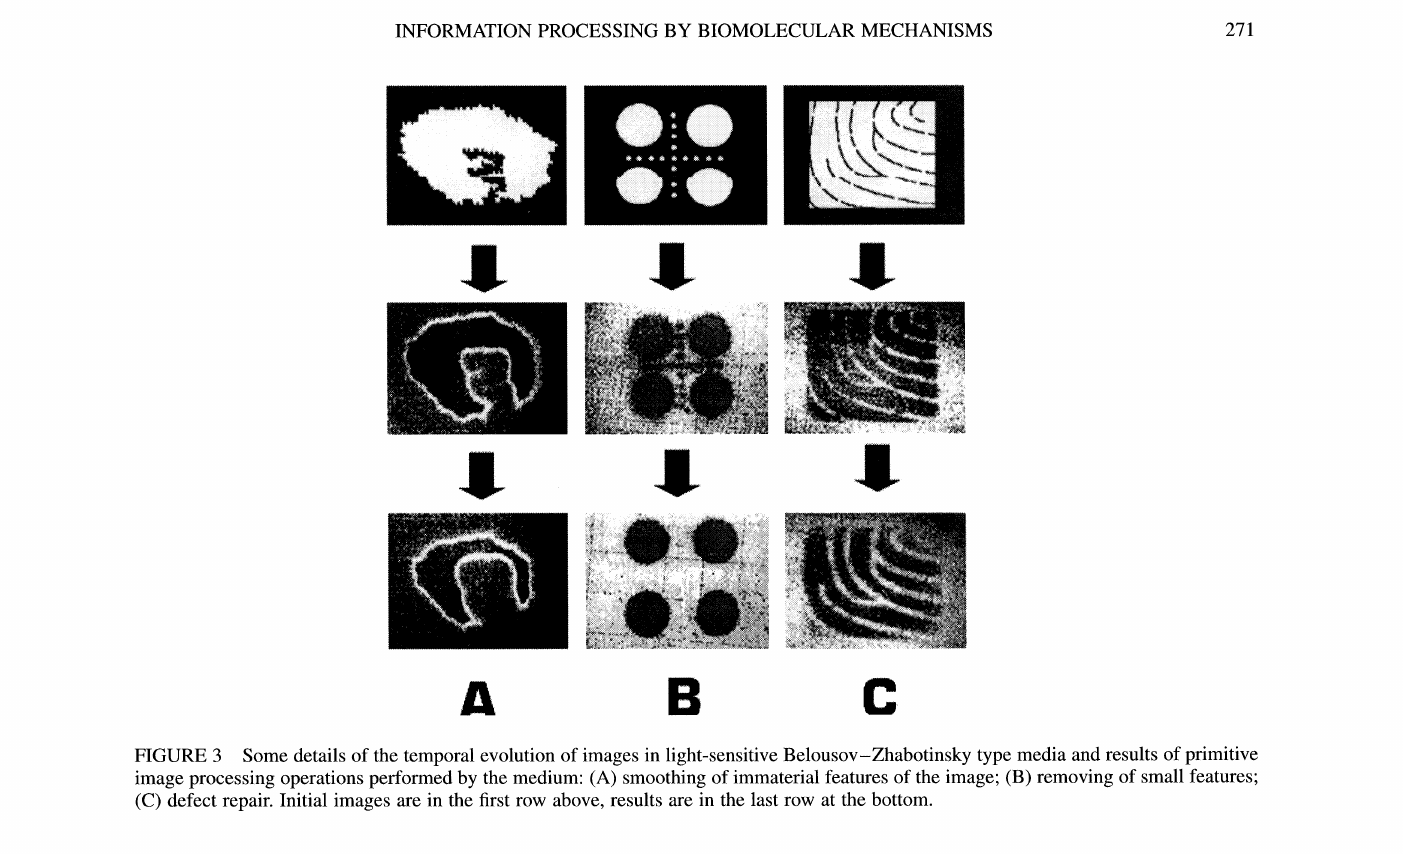
FIGURE 3 Some details of the temporal evolution of images in light-sensitive Belousov-Zhabotinsky type media and results of primitive image processing operations performed by the medium: (A) smoothing of immaterial features of the image; (B) removing of small features; (C) defect repair. Initial images are in the first row above, results are in the last row at the